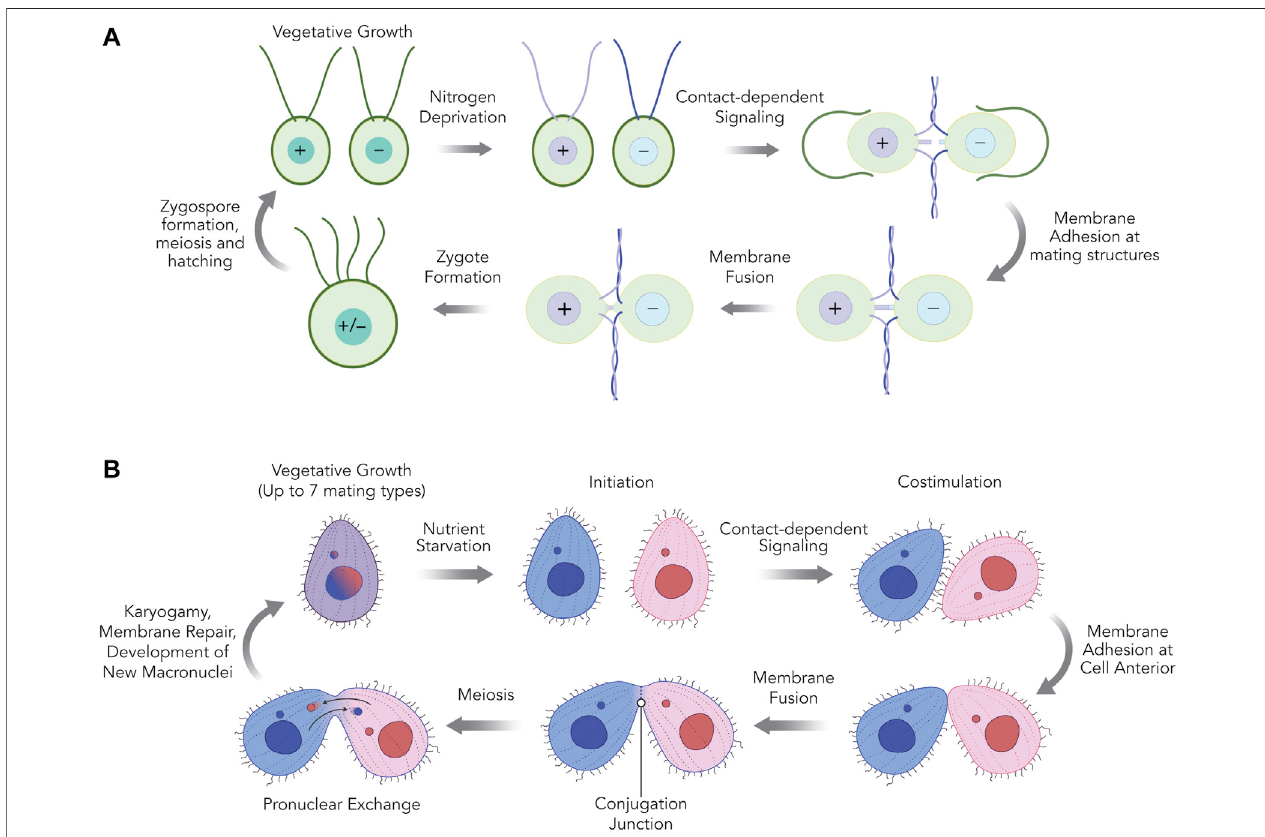
FIGURE 1 | The mating reactions of Chlamydomonas reinhardtii (A) and Tetrahymena thermophila (B) cells. (A) In C. reinhardtii , when asexually dividing haploid cells of plus or minus mating types are deprived of nitrogen, they undergo gametogenesis. After plus and minus gametes are mixed, adhesion between plus and minus cilia stimulate gamete activation; a cyclic AMP-dependent signaling pathway leading to cell wall loss, upregulation of gamete-speci fi c genes, and the maturation of a single membranous protrusion between the two cilia called the mating structure. The tips of the plus and minus mating structure membranes adhere and fuse quickly, producing a single quadriciliated zygote ( ∼ 10 min). Following ciliary resorption, zygotes develop into a resilient dormancy stage with a hard outer cell wall called the zygospore, which is maintained until environmentally favorable (nitrogen-replete) conditions return. Meiosis and hatching of the zygospore produces four haploid progeny cells (two minus and two plus ) capable of vegetative growth. (B) In T. thermophila, when asexually dividing cells of any of the seven different mating types are deprived ofnutrients they undergo “ initiation ” allowing subsequent sexual interactions. An initiated mating type can undergo conjugation with any of the other six mating types, but not their own. After initiated cells of two different mating types are mixed, physical interactions between the two cells further activate and mature the cells in a contact-dependent stage known as “ costimulation, ” leading to the upregulation of speci fi c genes and the maturation of a patch of membrane at the anterior end of the cellwherematingcellseventuallyadhere.Membraneadhesionisweakat fi rstbutthenbecomestight,andby ∼ 2.5 hcellpairsare fi rmlyjoinedatacrescent-shapedzone ofmembranestuddedwithhundredsoffusionporescalledtheconjugationjunction.Between5 – 6 haftermixing,haploidpronuclearproductsofmeiosismadeineachof thetwopartnercellsareexchangedacrosstheconjugation junctionand fusetoastationaryhaploid pronucleusinthepartnertocreate azygoticnuclearproduct. These zygotic nuclei undergo further differentiation within their respective cells and at about 10 – 11 h after mixing, the membrane fusion pores at the conjugation junction are repaired and the two cells separate from one another. Upon return to nutrient-replete conditions, the exconjugant cells immediately divide, generating four progeny “ karyonide ” cells capable of vegetative